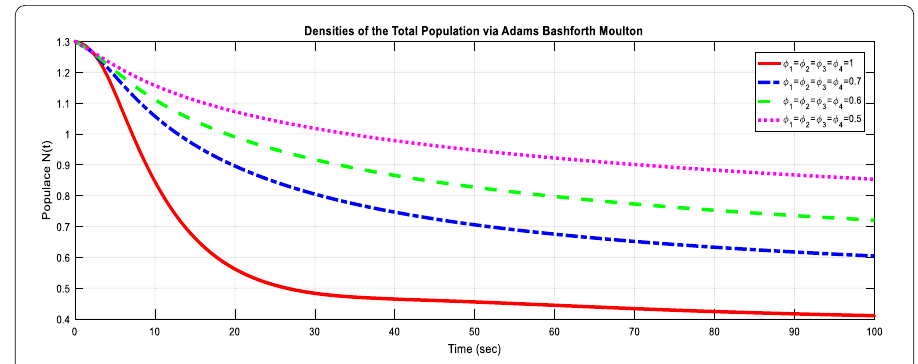
Figure 33 Dynamic of populace N ( t ) by varying the value of φ